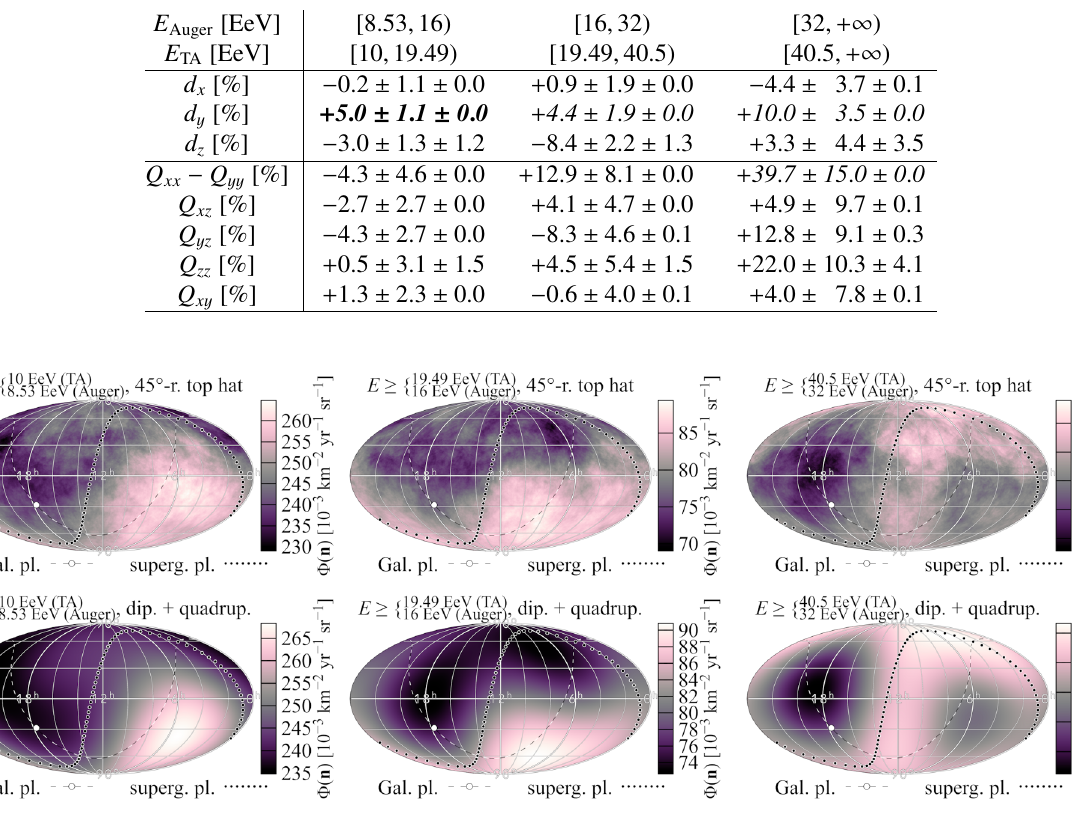
Figure 2. The observed flux in the three energy bins used for the large-scale anisotropies (top panels), and the reconstructed directional flux truncated to ℓ ≤ 2 (bottom